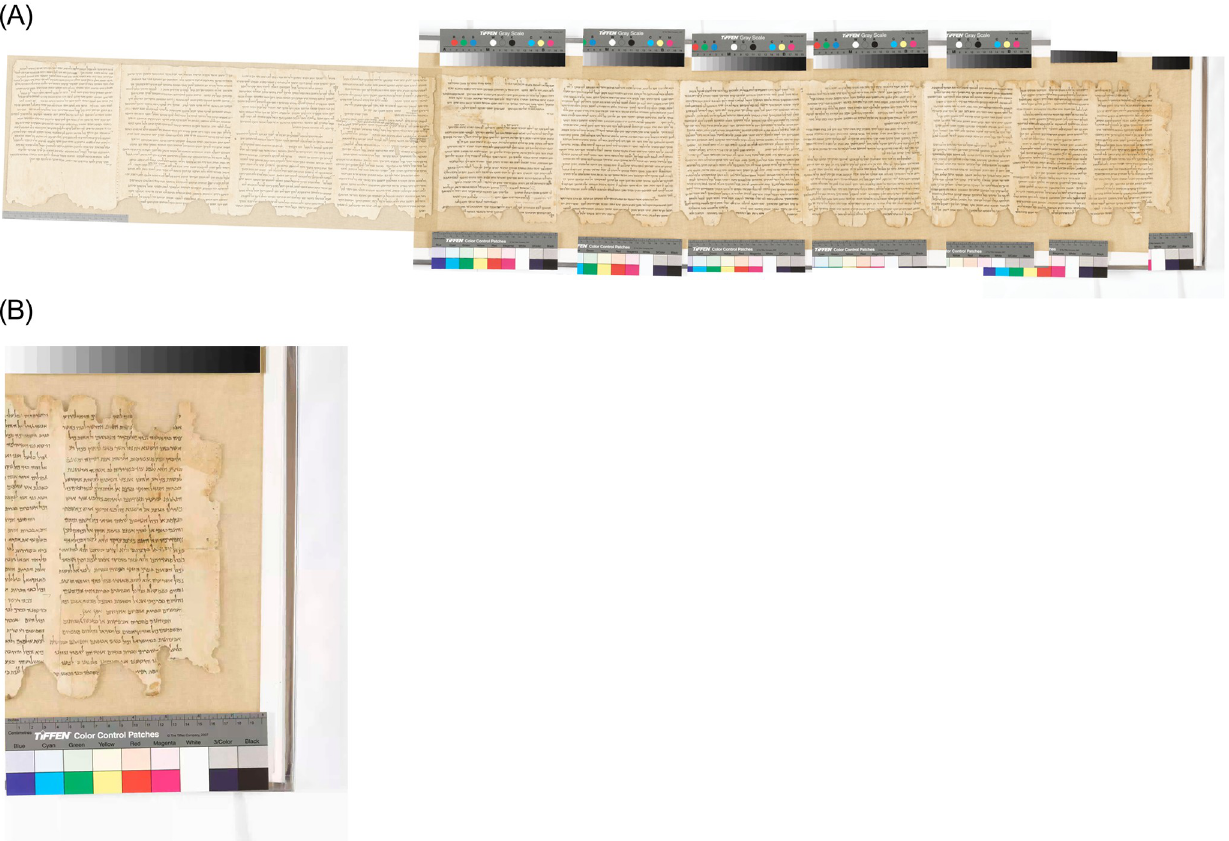
Fig 2. Community Rule , 1QS. (A) Left: full scroll. (B) Right: closeup, showing damage patterns and ruler. (Courtesy Shrine of the Book, Israel Museum. Photographer: Ardon Bar-Hama.).